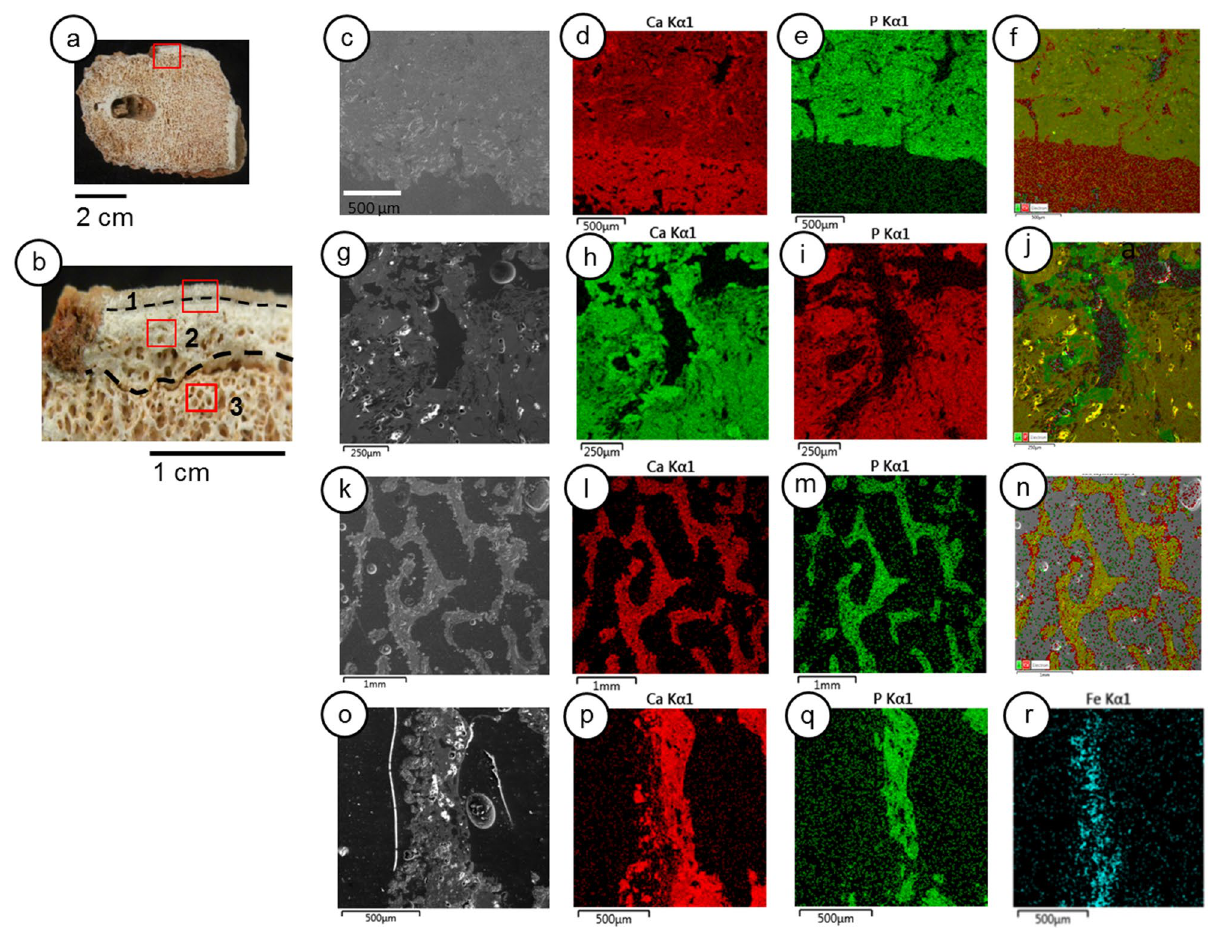
Figure 4. Scanning electron microscopy (SEM) and geochemical mapping by energy dispersive X-ray spectroscopy (EDS) of the LAPA/SBF-3-0017 sample. ( a )—Internal surface of the sample with the selected area for analyses (red box). ( b )—Red box in detail shows the three different selected areas (red boxes) for SEM analysis: layer 1—external surface of the bone ( c – f ); layer 2—cortical and intermediate layers ( g – j ), layer 3— internal cancellous tissue ( k – n ), in more detail ( o – r ). ( a )—SEM image of calcite precipitate layer 1 and part of the cortical bone, layer 2. ( d , e ) Ca and P distributions. ( f )—Both Ca and P in the same mapping; note the intense Ca infillings inside the cortical bone pores. ( g )—Backscattered electron image of the cortical bone, layer 2. ( h , i )—Ca and P distributions. ( j )—Ca and P in the same mapping, observe the calcite precipitate in the pores. ( k )—SEM image of the cancellous bone, layer 3. ( i ), ( m )—Mapping of Ca and P, respectively. ( n )—Both Ca and P in the same mapping. ( o )—Detailed SEM image of the cancellous bone surface. ( p , q )—Geochemical mapping of Ca and P, respectively. ( r )—Mapping of